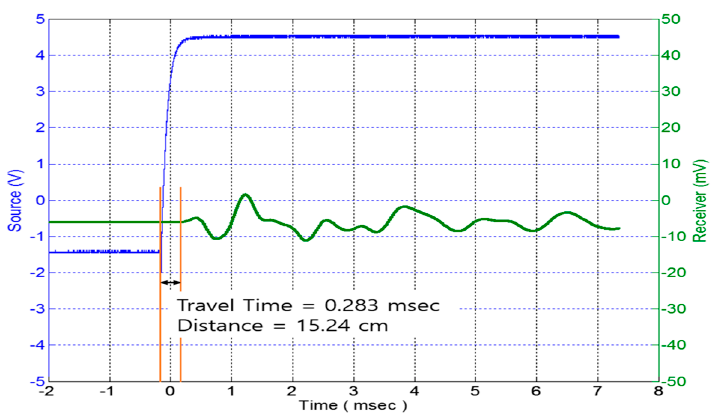
Figure 21. Compression wave speed measured by piezoelectric stack.